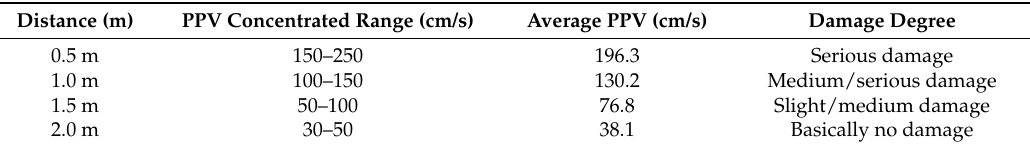
Table 3. Estimation of damage degree by PPV for the bedded